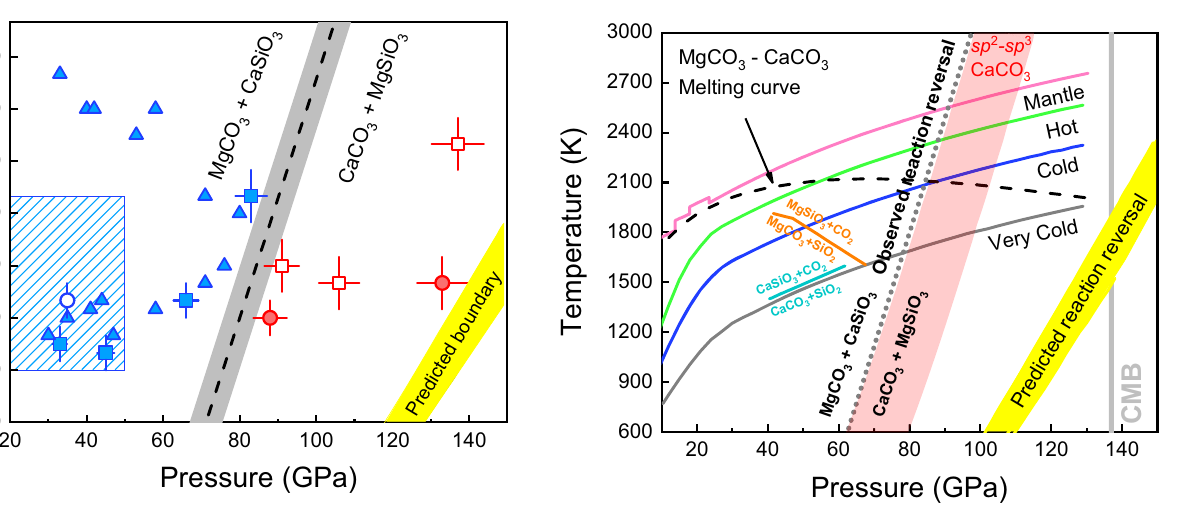
Fig. 3 Pressure – temperature diagram of reactions between carbonate, silicates, and silica in the subducted oceanic crust to the lower mantle. The gray dotted line indicates the reversal boundary of the carbonate – silicate exchange reaction proposed by this study, whereas previous theoretical predictions are illustrated by yellow-shaded region 28 – 30 . The cyan and orange lines indicate the decarbonation reactions of CaCO 3 + SiO 2 40 and MgCO 3 + SiO 2 41 , respectively. The black dashed line shows the melting curve of MgCO 3 – CaCO 3 system constrained by Thomson et al. 22 . Four typical mantle geotherms are modi fi ed from Maeda et al. 36 . The red-shaded region indicates the transition boundary of CaCO 3 from sp 2 to sp 3 structure predicted by density functional theory computations 29,38